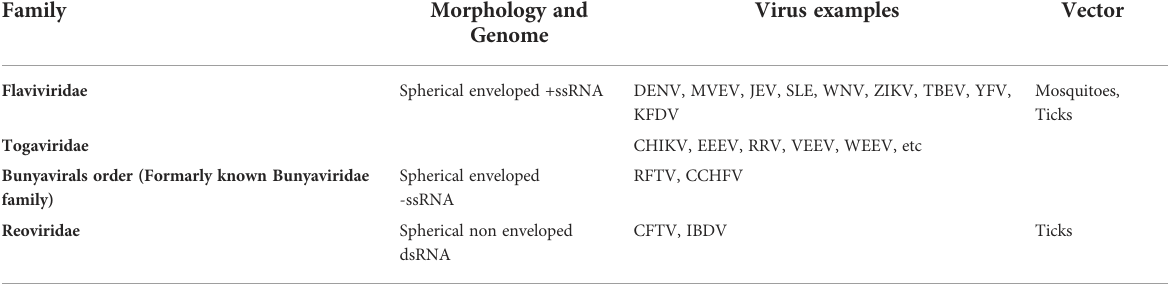
TABLE 1 Virus families containing economically important arboviruses.